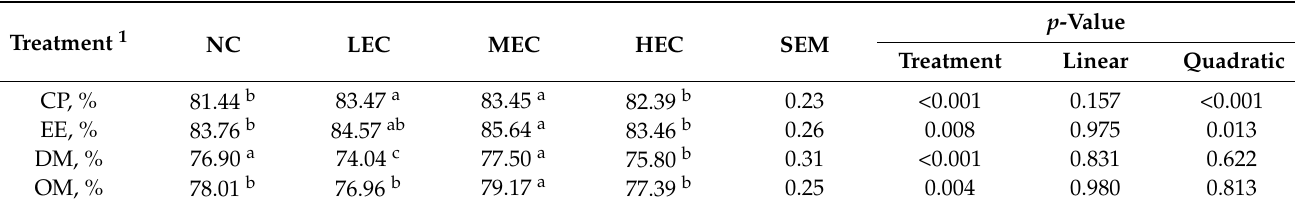
Table 5. The effects of different gelatinization degrees of extruded corn on the ATTD of CP and EE in piglets in experiment 2.